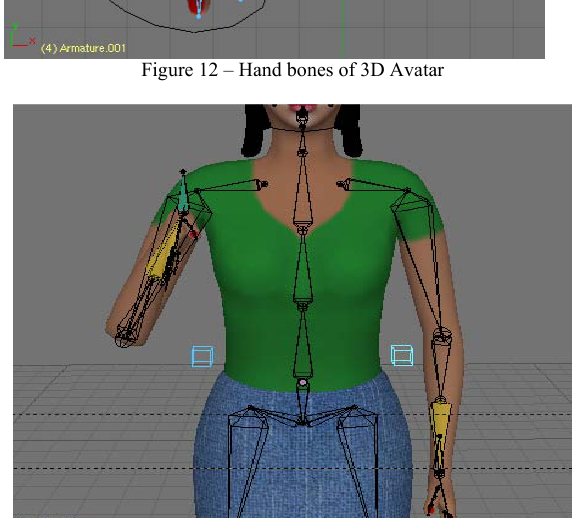
Figure 13 – Auxiliary bones